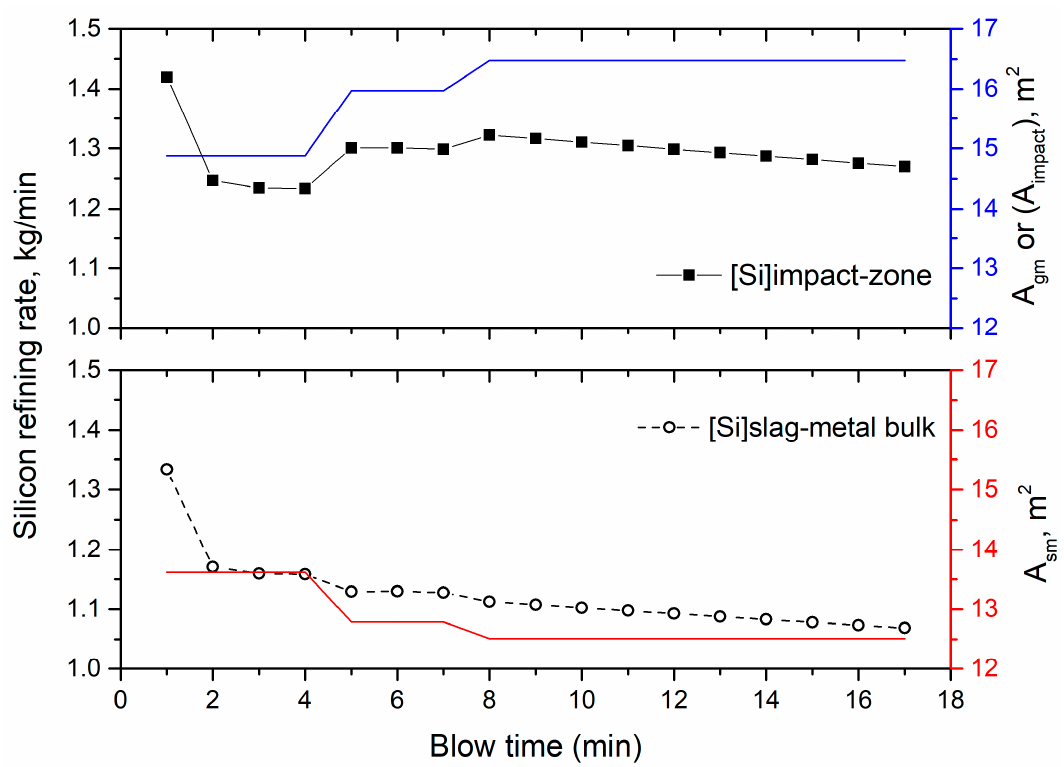
Figure 11. Variation of area and contribution to refining by impact and slag-metal bulk zones.